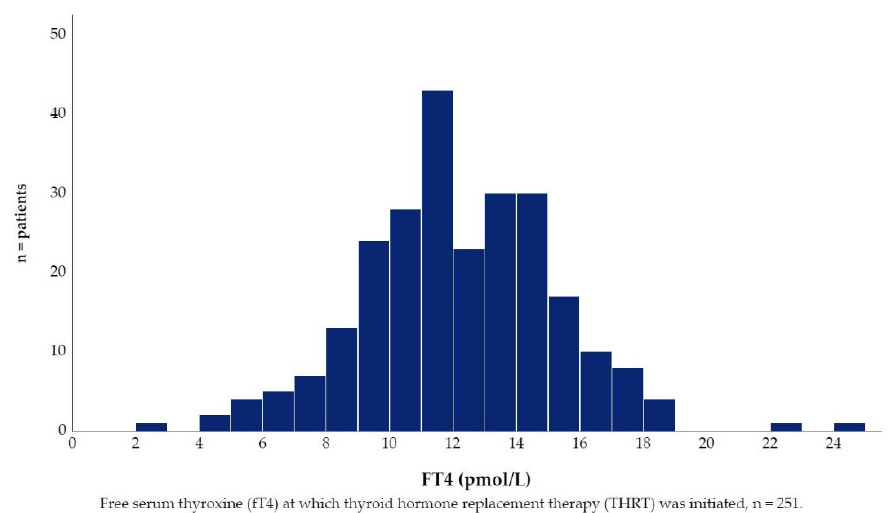
Figure 5. FT4 distribution at Thyroid Hormone Replacement Therapy start.